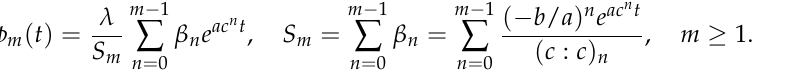
Figure 5. Plots of the approximate solutions φ m ( t ) , m = 3,4,5,6 in Equation (39) vs. t at λ = 1, c = 3 b = 1, and a = − 2.